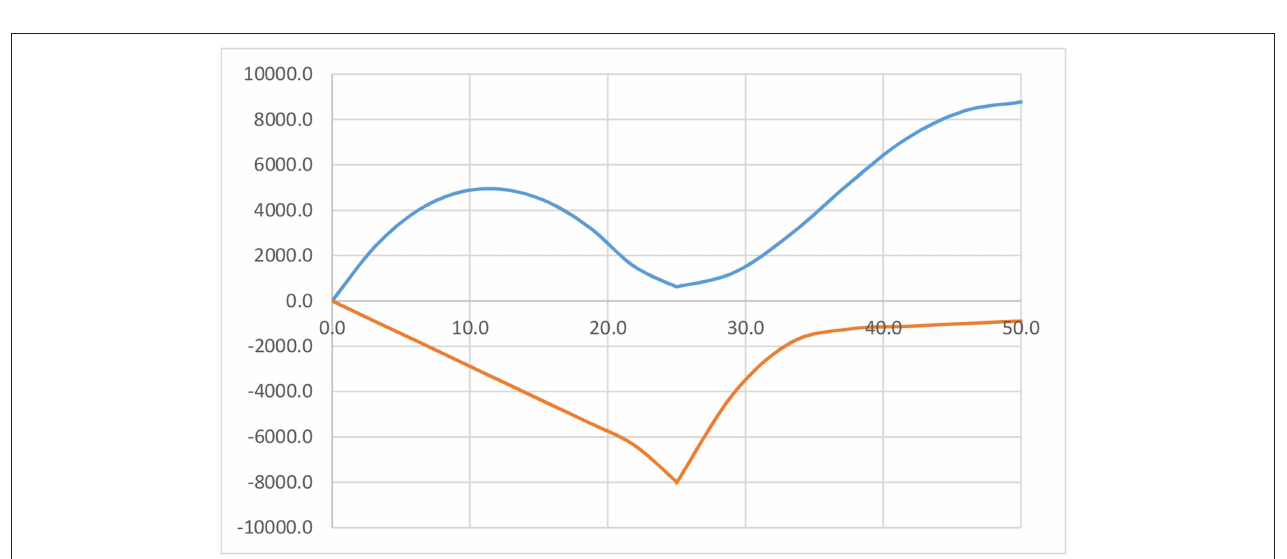
FIGURE 3 | Envelope curve variable